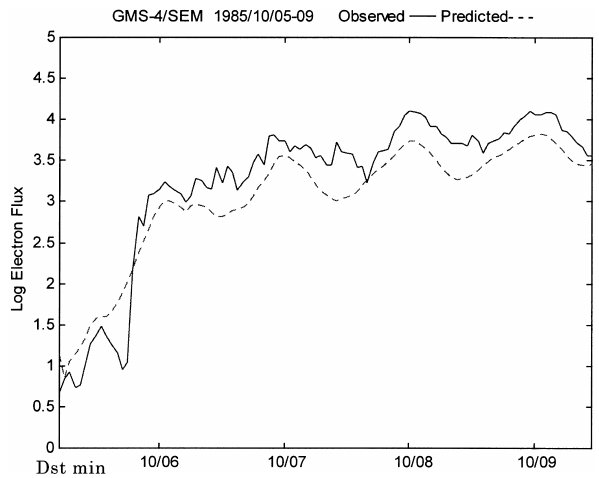
Fig. 4. The storm of 5–9 Oct 1985 for which the best predictability was obtained. The solid and dashed curves represent the observa- tion and one-hour forward prediction,